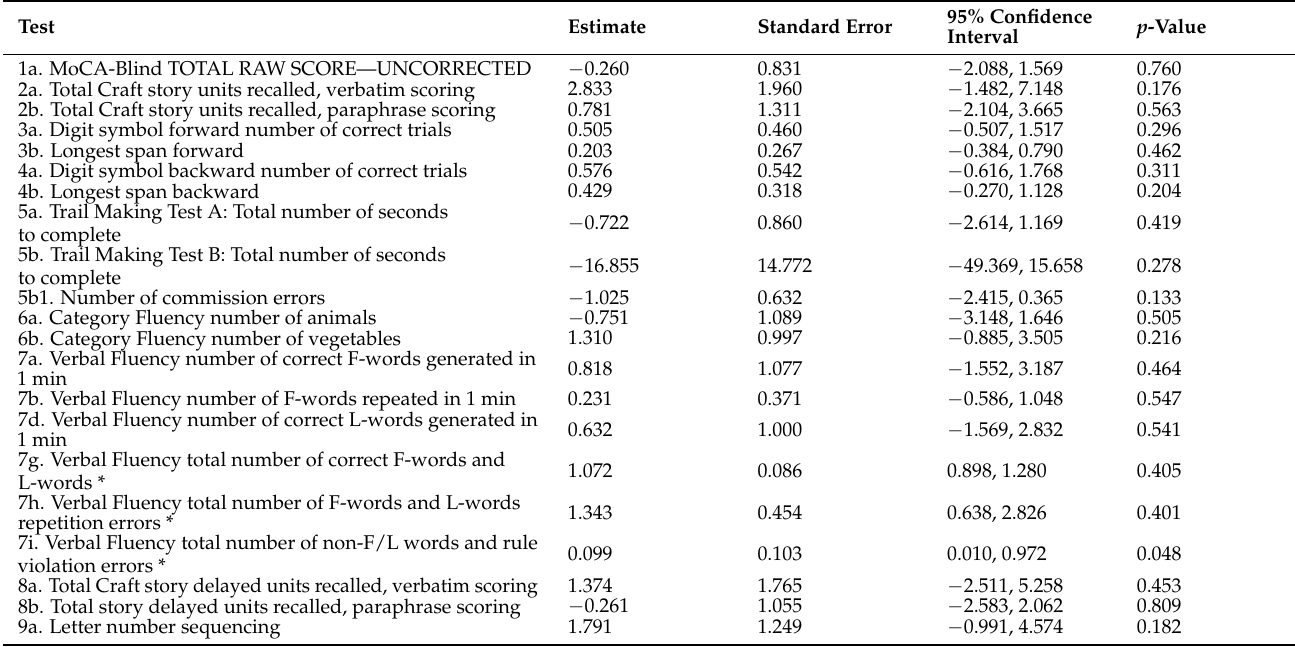
Table 7. Cognitive scores—change from baseline estimates.